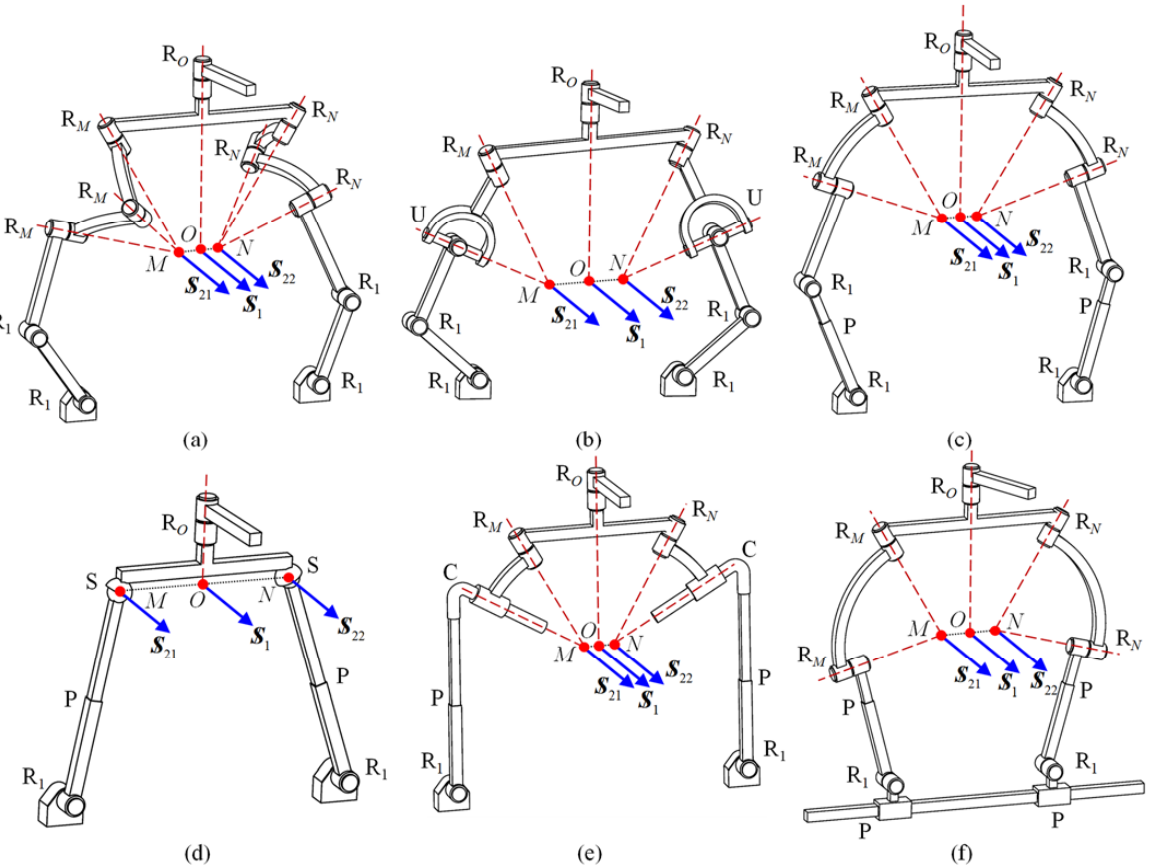
Figure 4. Typical F ‐ hybrid limbs in the second class: ( a ) [R 1 R 1 R M R M R M ‐ R 1 R 1 R N R N R N ] ‐ R O , ( b ) [R 1 R 1 UR M ‐ R 1 R 1 UR N ] ‐ R O , ( c ) [R 1 PR 1 R M R M ‐ R 1 PR 1 R N R N ] ‐ R O , ( d ) [R 1 PS ‐ R 1 PS] ‐ R O , ( e ) [R 1 PCR M ‐ R 1 PCR N ] ‐ R O , ( f ) [PR 1 PR M R M ‐ PR 1 PR N R N ] ‐ R O